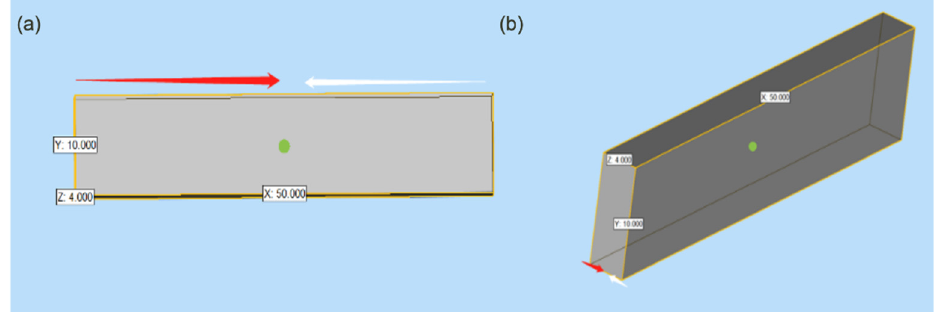
Figure 2. Interfacial orientations of duotone specimens. ( a ) vertical interface between white and pink parts; ( b ) horizontal interface between white and pink parts.